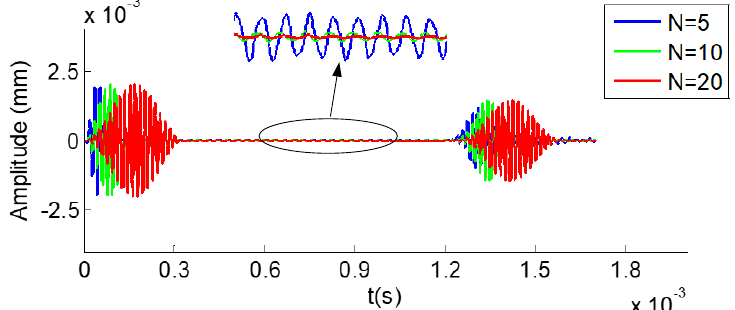
Figure 10. Time domain waveform received from a hexagonal drill pipe under the excitation of tone burst with different